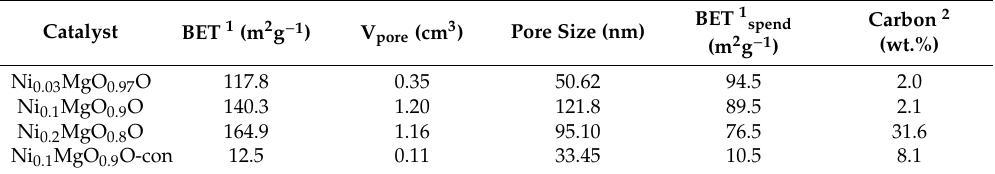
Table 1. Structural properties of Ni x Mg 1 − x O catalysts.